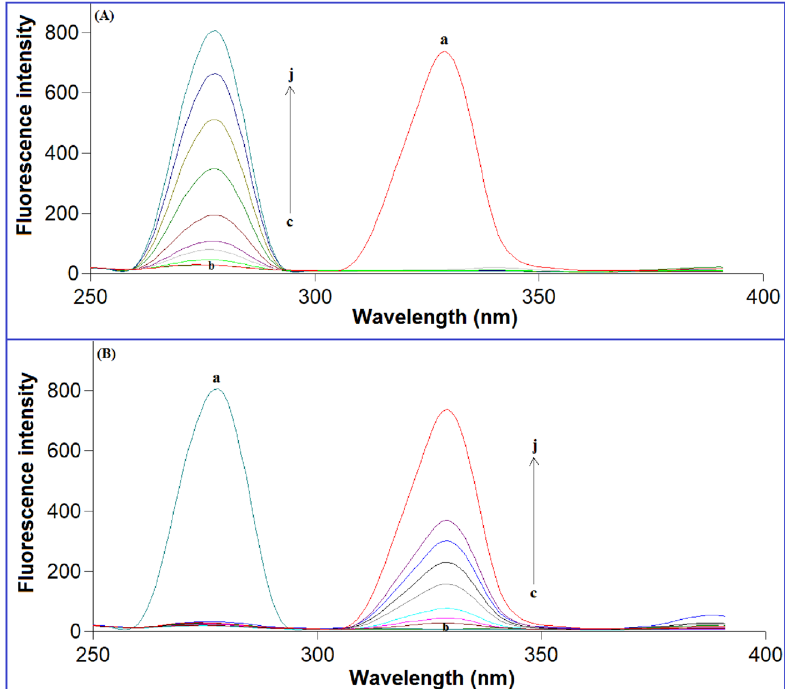
Figure 5. Synchronous fluorescence spectra of: ( A ) (a) AGM (200.0 ng/mL), (b) Blank, and (c-j: 20.0, 50.0, 100.0, 200.0, 400.0, 600.0, 800.0, 1000.0 ng/mL VFX) at Δλ = 20 nm, ( B ) (a) VFX (1000.0 ng/mL), (b) Blank, and (c-j: 5.0, 10.0, 20.0, 40.0, 60.0, 80.0, 100.0, 200.0 ng/mL AGM) at Δλ = 20